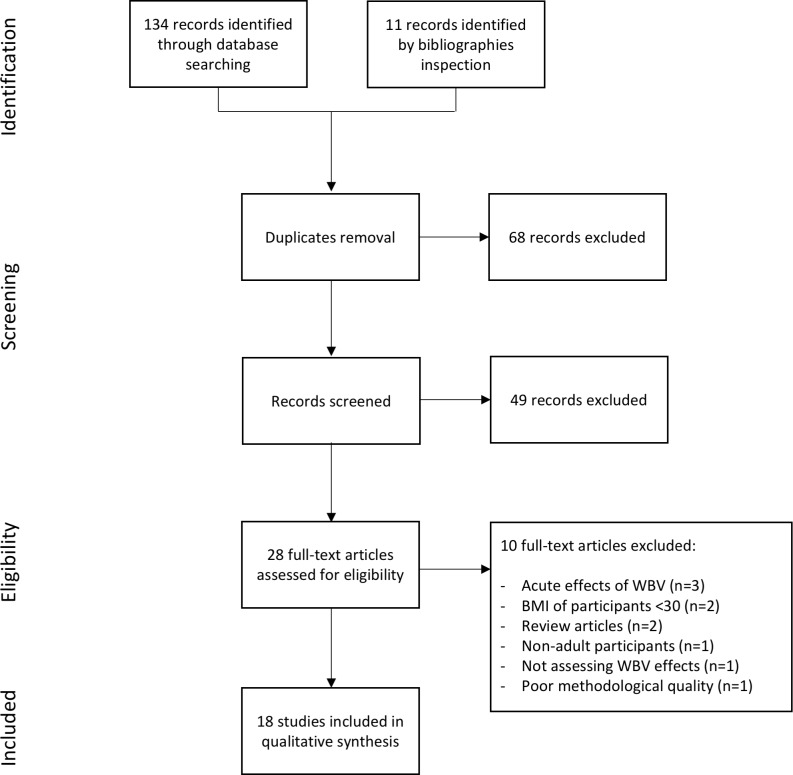
PRISMA diagram of study selection.